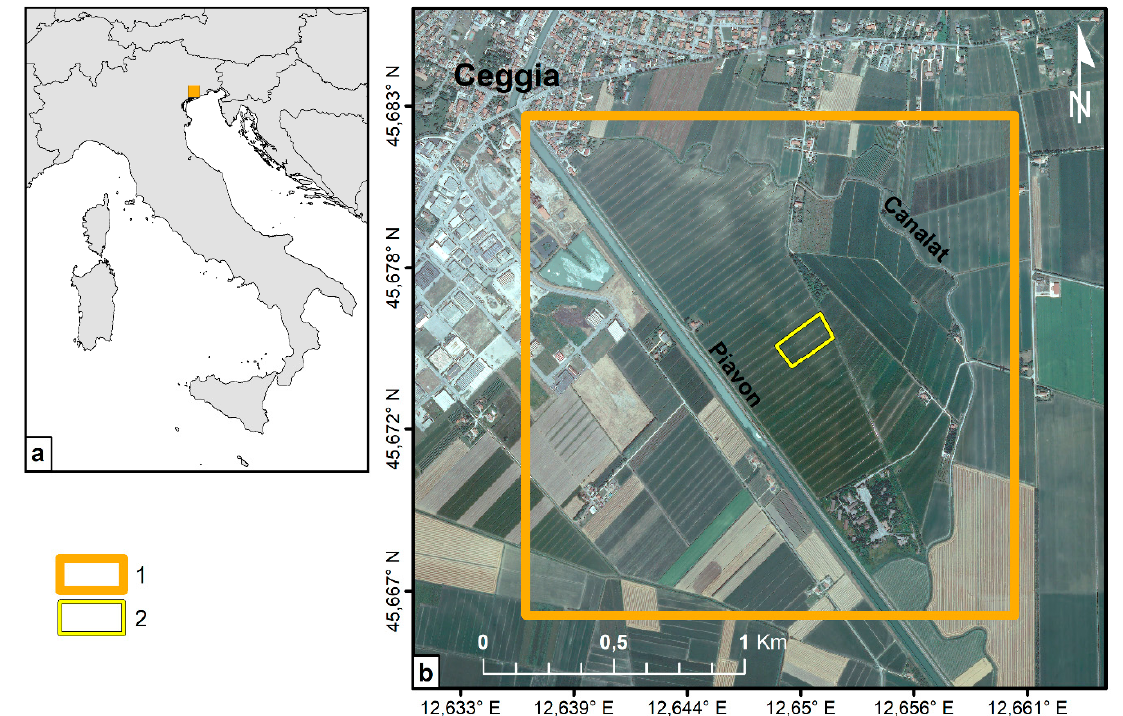
Figure 1. ( a ) Location of the study area. ( b ) Agea 2012 digital color orthophoto: (1) the study area; (2) the site investigated with geophysical prospections, core drilling, and stratigraphic analysis of